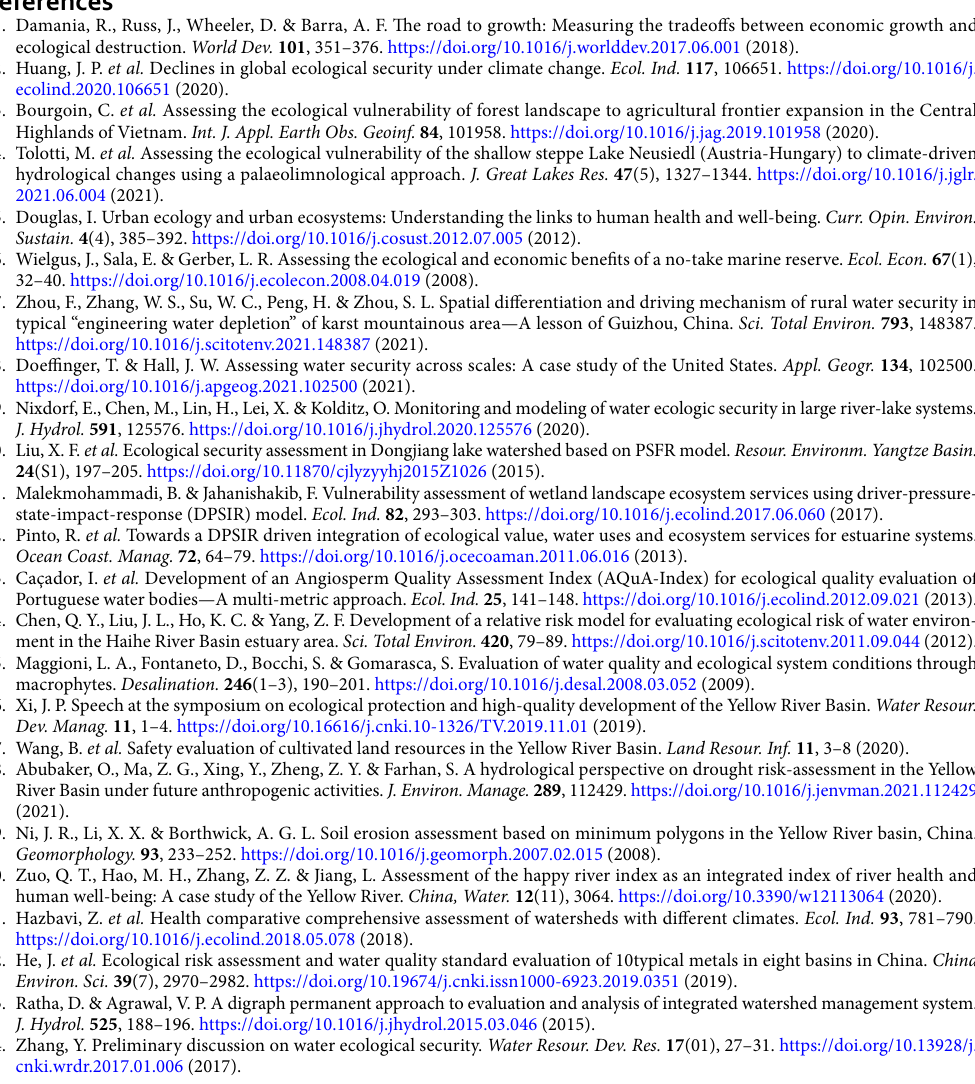
(a) The water ecological security of 62 cities is concentrated in three levels: medium early warning, early warning, and relative safety. Relatively safe areas are concentrated in the western and northern parts of the Yellow River Basin. The moderate early warning areas are mainly concentrated in the central and eastern regions of the Yellow River Basin. The rest are warning areas. (b) Wetland area is a crucial factor affecting water ecological security for a long time. The impact of the green area rate of built-up area on ecological security increases year by year, and 2019 (0.9) becomes the essential factor. (c) The Water Ecological Security Index (WESI) of 62 cities in 2019 increased by 5.96% compared to 2009, but the average annual growth rate was only 0.59%. (d) The results of spatial autocorrelation analysis of water ecological security in 62 cities show that the cities in the upper reaches of the Yellow River present a high degree of spatial aggregation and positive spatial correlation, and the water ecological security status is relatively good. (e) The water ecological security of some cities to the west, north, and east of the Yellow River Basin is concen- trated areas significantly affected by pressure, state and response. The response layer has the most significant changes in time and space, indicating that the relevant management and governance measures and measures adopted by the relevant departments have the most significant impact on the water ecological security of each